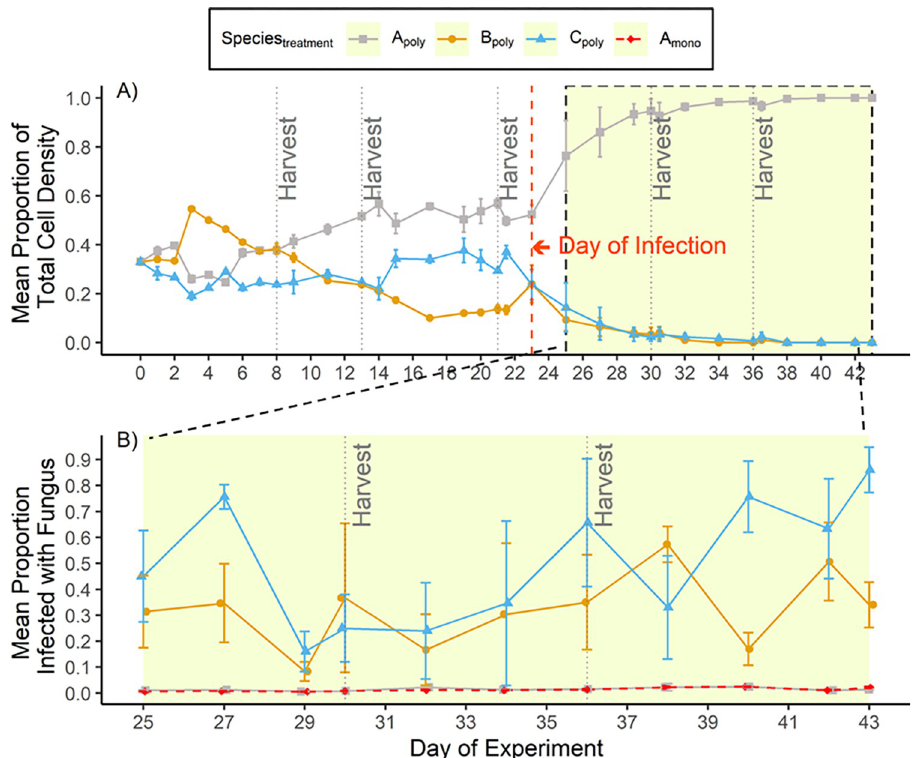
Fig 3. Time series of algal cell densities and infection metrics. Panel A shows the grand mean proportion of total cell density that is composed of each species in polyculture. Panel B shows the grand mean proportion of each species infected with the fungus in both polycultures and monocultures Bars represent the standard error. Highlighted yellow section of both graphs represents the experimental period post infection. Vertical light-grey dotted lines indicate harvest days. Data collected on harvest days are pre-harvest. Vertical red dashed line represents the day of infection (day 23). Infection proportions in panel B are only shown for the After Infection Period because no significant signs of infection were detected prior to day